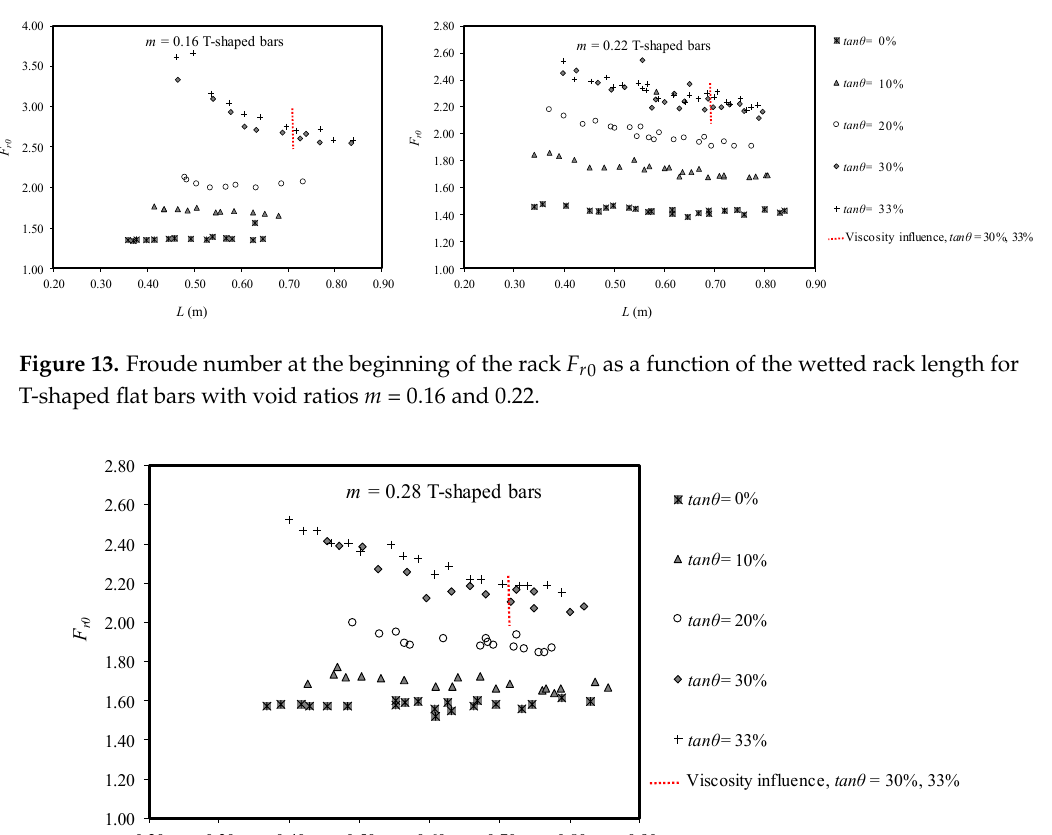
Figure 12. Froude number at the beginning of the rack F r0 as a function of the wetted rack length for circular bars with void ratios m = 0.28 and 0.60.